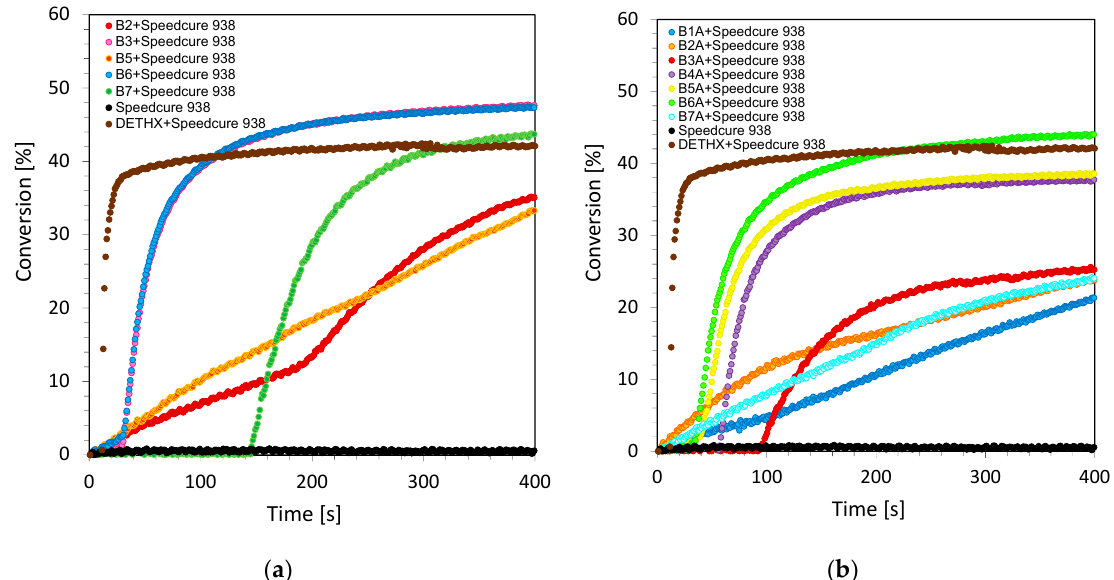
Figure 6. Free-radical photopolymerization profiles (acrylate function conversion vs. irradiation time) for TMPTA with the bimolecular photoinitiating system based on ( a ) series 1 of 2-amino-4-methyl-6-(4-phenylphenyl)benzene-1,3-dicarbonitrile derivatives and Speedcure 938 (0.1%/1% w/w) under visible light LED source 405 nm; ( b ) series 1 of 2-amino-4-methyl-6-(4-phenylphenyl)benzene-1,3-dicarbonitrile derivatives and Speedcure 938 (0.1%/1% w/w) under visible light LED source 405 nm.